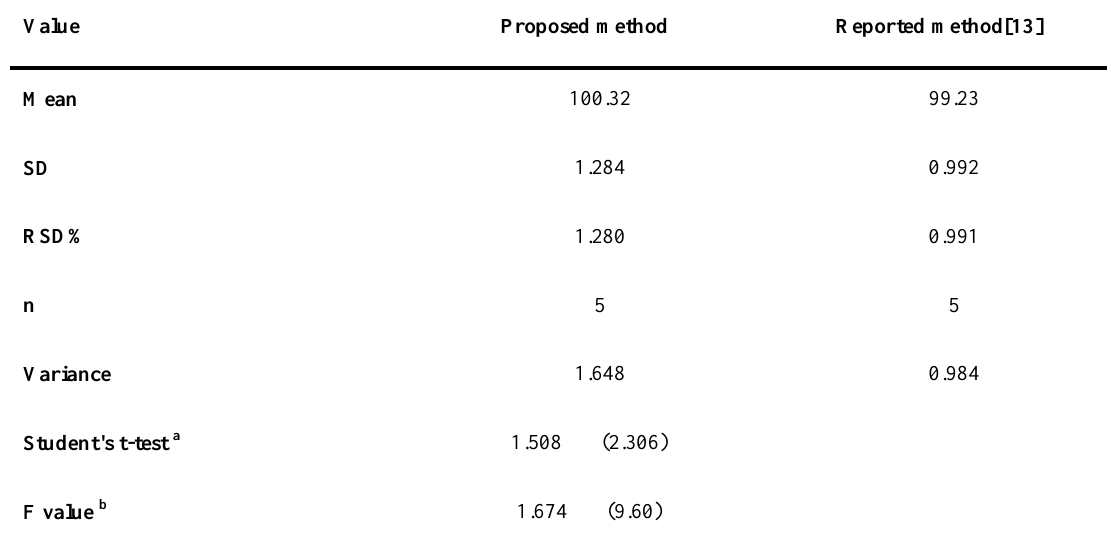
Table 5. Statistical comparison of the results obtained by applying the proposed method and the reported method for the analysis of pure